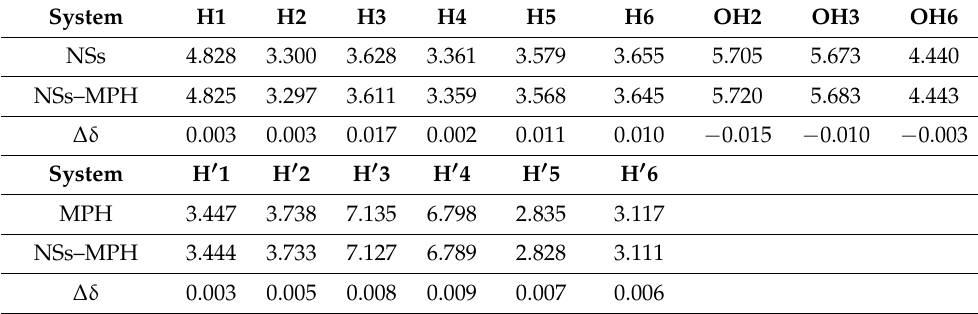
Table 1. Proton assignments and chemical shifts for NSs, MPH and NSs–MPH.